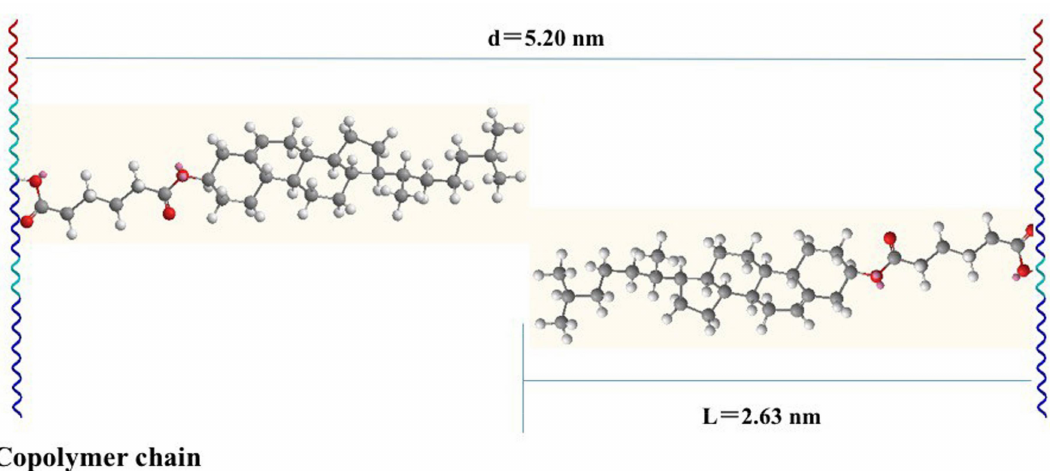
Figure 5. Schematic representation of the doubled SmA layer arrangements of mPEG 43 - b -P[(TMC-C) 20 -TMC 20